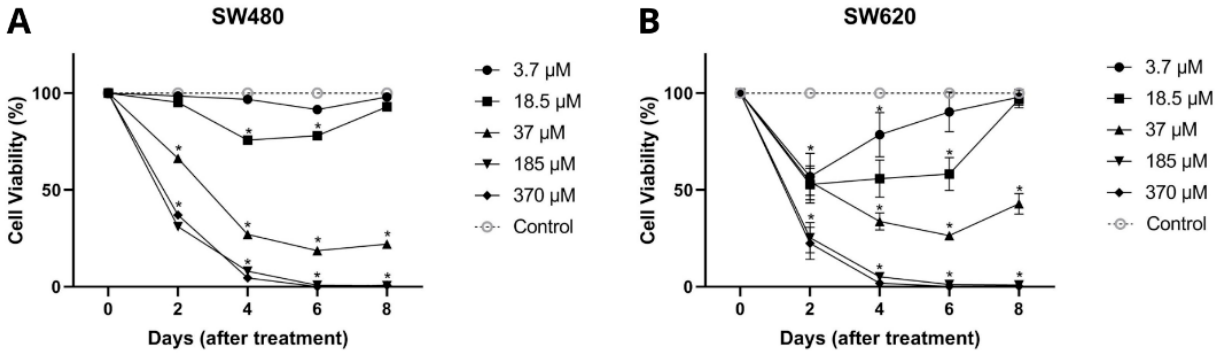
Figure 5. Antiproliferative effect of genistein. ( A ) Colorectal adenocarcinoma cell line SW480. ( B ) Colorectal adenocarcinoma cell line SW620. All tests were performed in quintuplicate. p -value < 0.0001 *.